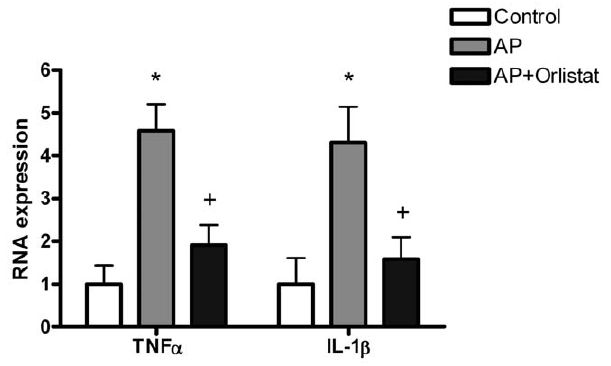
Figure 2. RNA expression of TNF a and IL1 b in peritoneal macrophages was significantly induced during acute pancre- atitis (AP). Lipase inhibition with Orlistat prevented this activation. * = p , 0.05 vs control; + = p , 0.05 vs AP.